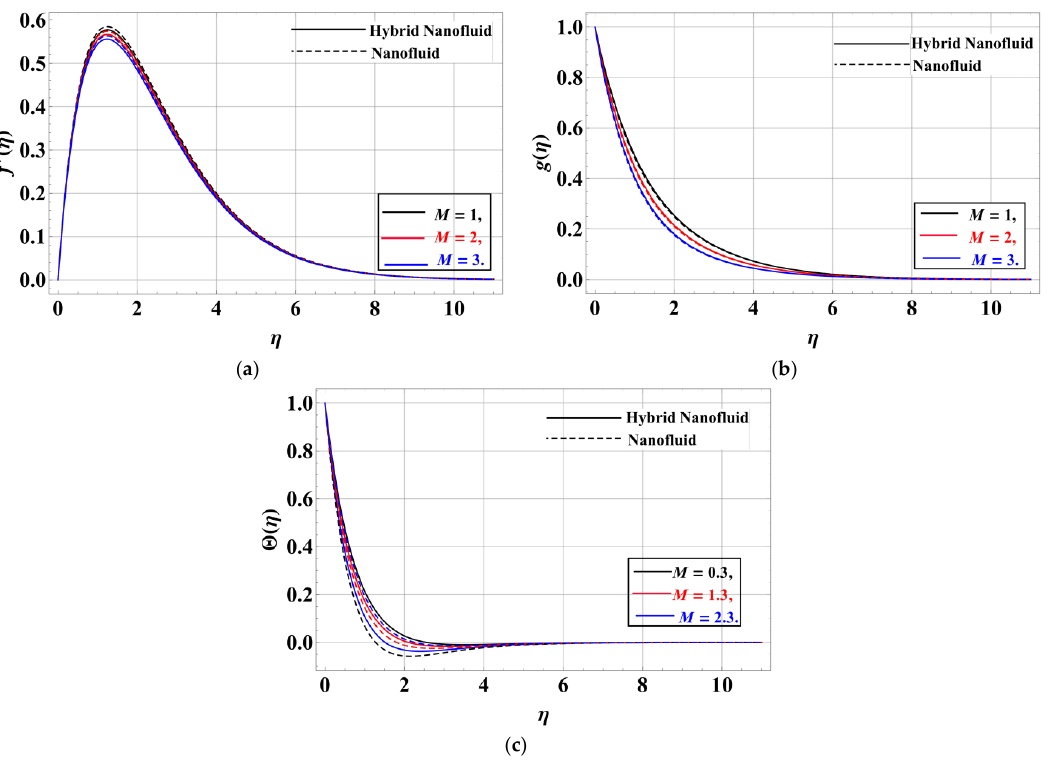
Figure 5. Variations in f (cid:48) ( η ) , g ( η ) & Θ ( η ) against M . ( a ) Variations in f (cid:48) ( η ) against M ( b ) Variations in g ( η ) against M ( c ) Variations in Θ ( η ) against M .